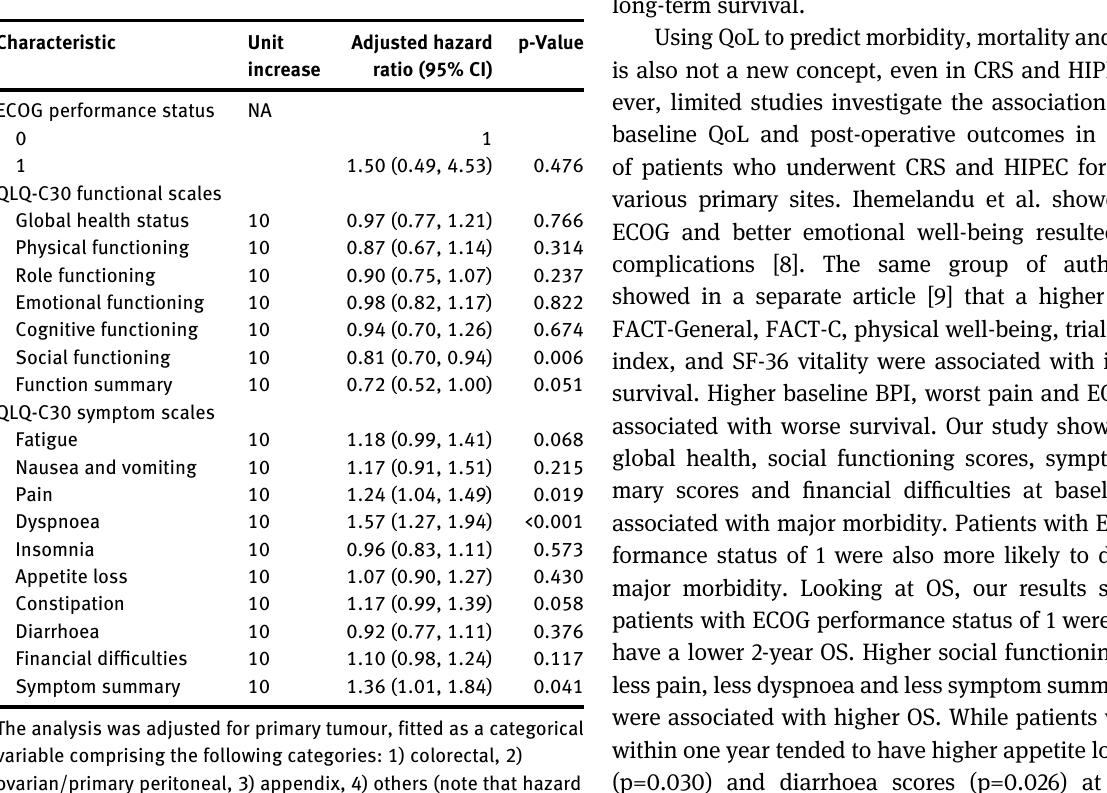
Table  : Association between ECOG performance status, QoL at baseline and overall survival, adjusted for primary tumour. Lower social functioning score, and higher pain, dyspnoea and symptom summary scores at baseline were signi fi cantly associated with poorer